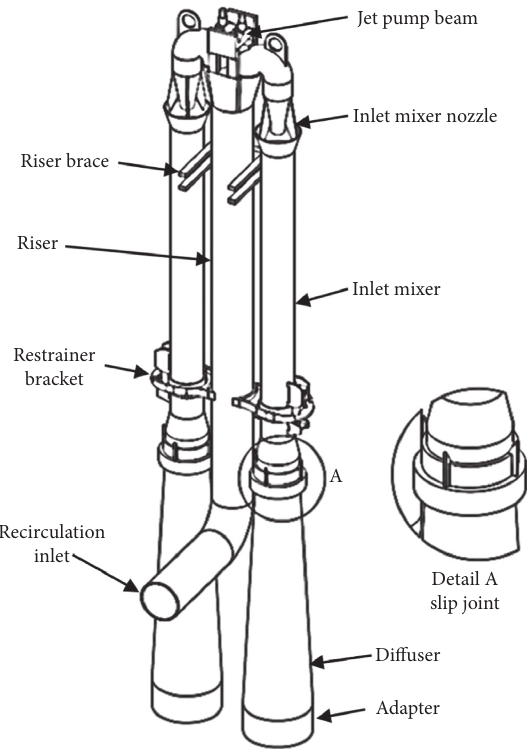
Figure 1: Jet pump